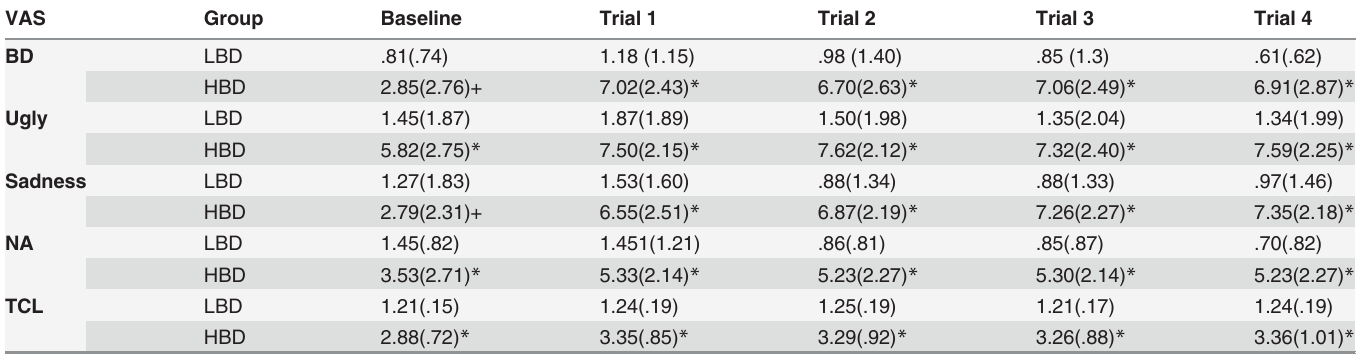
Table 1. Mean (and standard deviation) of Body Dissatisfaction (BD), Ugly, Sadness, and the aggregated Negative Affect (NA) VAS scores and the negative Thoughts Checklist (TCL) scores for the low body dissatisfaction (LBD) and high body dissatisfaction (HBD) groups. VAS